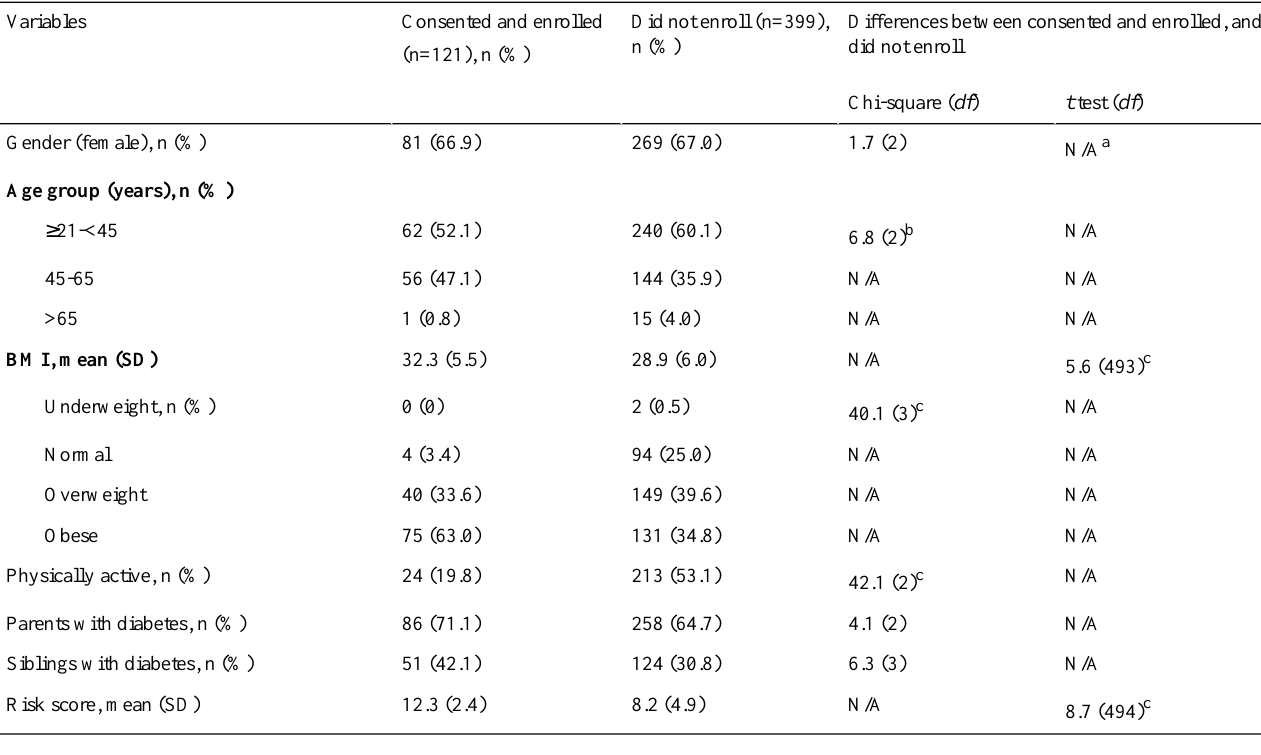
Table 3. Comparison of individuals who were eligible for enrollment in a diabetes prevention program (risk score>9) and agreed to be contacted (n=121) and those who did not enroll in the program